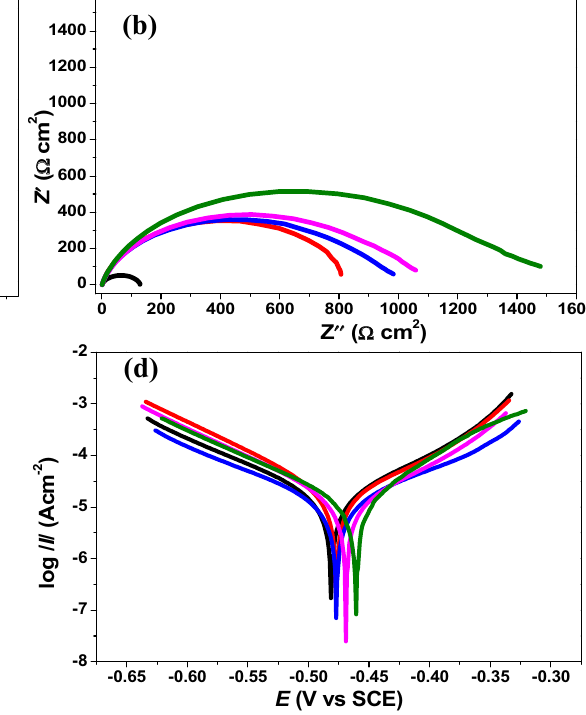
Fig. 7 a OCP vs time plot b Nyquist plot and c Equivalent circuit used to fit data and d Tafel plot for the corrosion of X80 steel in blank 1 M HCl and 1 M HCl inhibited using Et-ACPE and Et-AgNPs.